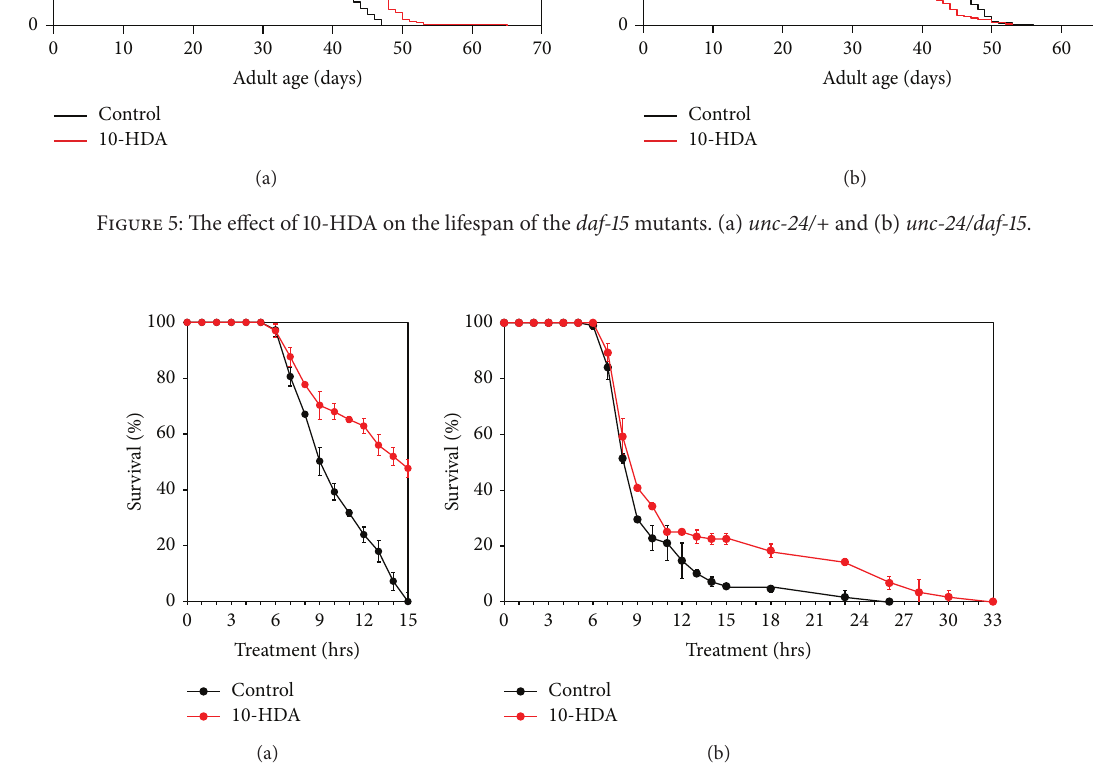
Figure 6: (a) Thermal stress. (b) Oxidative stress. Treatment with or without 25 𝜇 M 10-HDA began at the egg stage. Mean values and SD of triplicate samples are